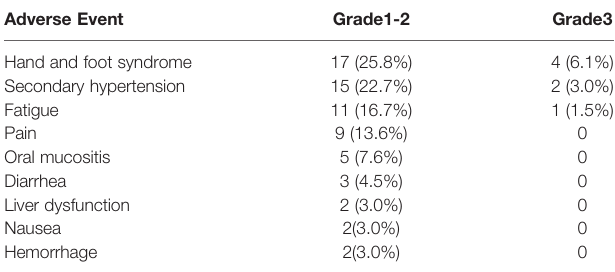
Figure3 .In Table4 ,anumberofpriorchemotherapyregimensless than or equal to 3 seemed to be associated with a longer PFS (9 vs . 6 months, P = 0.0017) or OS (17 vs. 8 months, P < 0.0001). Patients withbrainmetastasishadapoorerprognosisintermsofDFS(5 vs .6 months, P = 0.0472) and OS (6.5 vs. 10.0 months, P=0.0303). The patients with an NLR>3.78 (P=0.0221), a number of organs in primary recurrence>1 (P = 0.0238), a number of organs >1 before apatinib (P = 0.0365), had a poorer OS (P < 0.05). Apatinib were